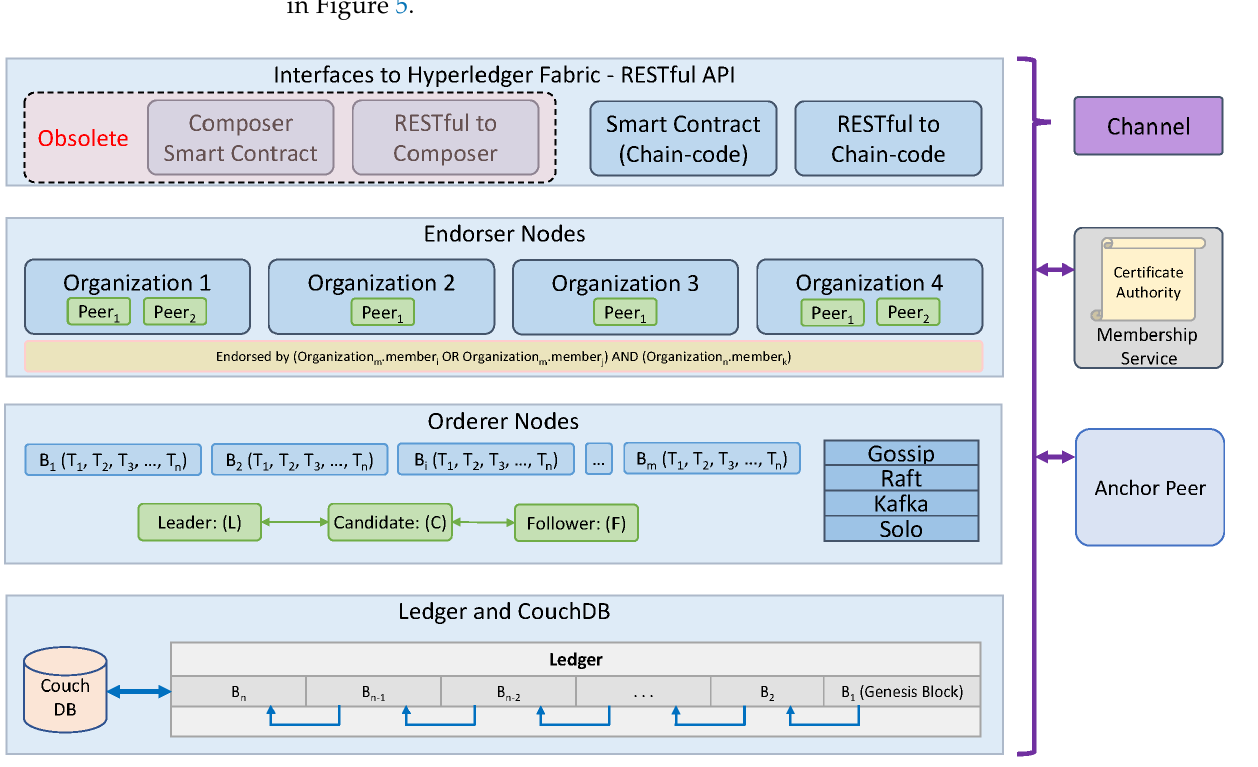
Figure 5. The modular diagram of the deployed Hyperledger with showing various internal